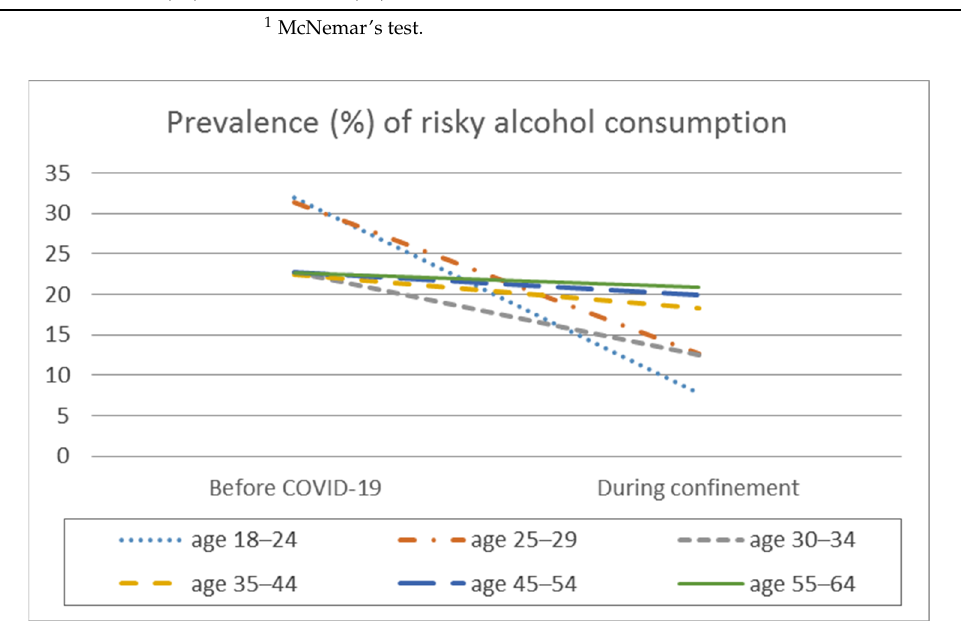
Figure 5. Prevalence (%) of risky alcohol consumption by age before the pandemic and during COVID-19 confinement.